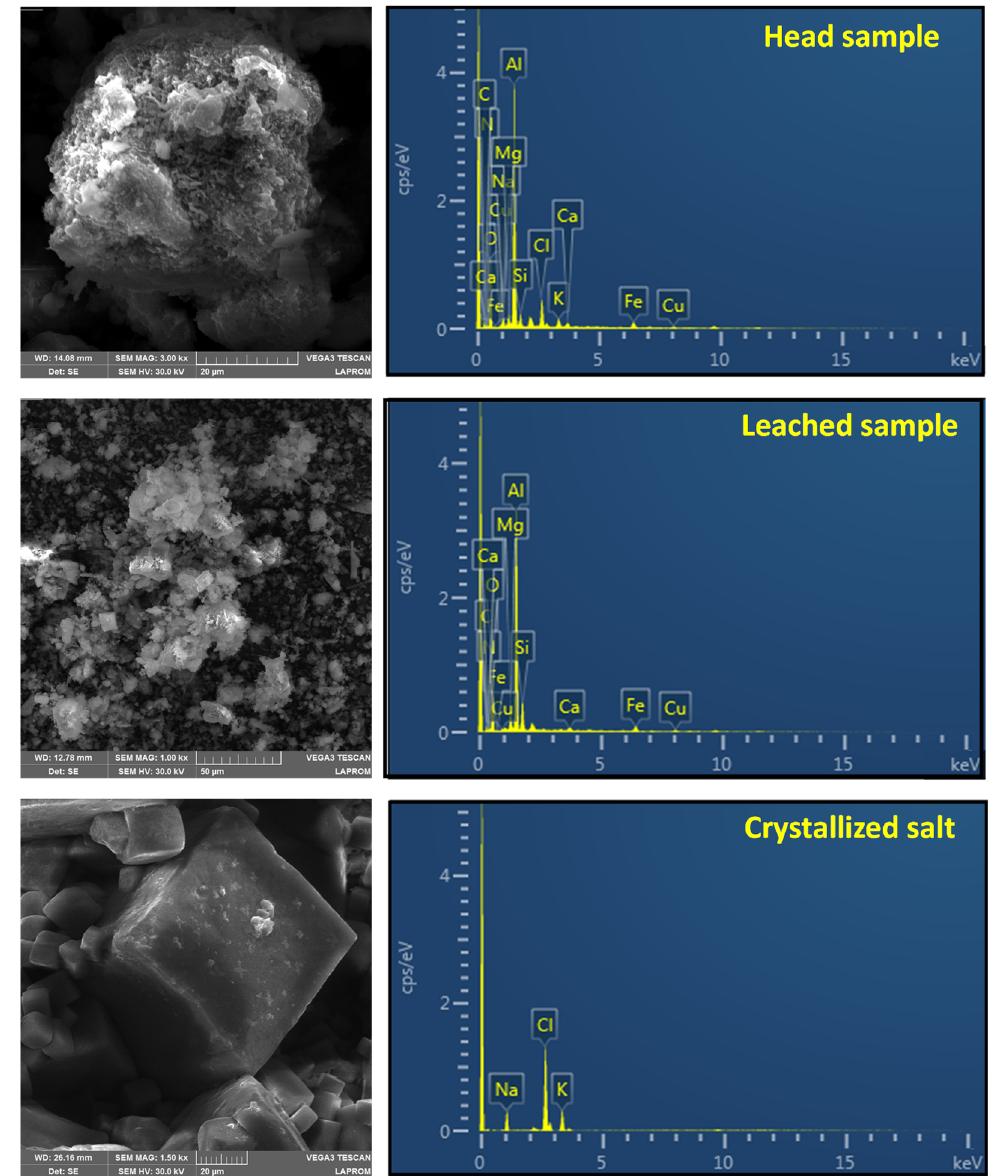
Figure 8. Scanning electron microscopy images (SEM) and elemental analysis (EDS) of raw slag (head sample), leached slag, and crystallized salt. The grain size is 20 µm, 50 µm, and 20 µm, re- spectively.